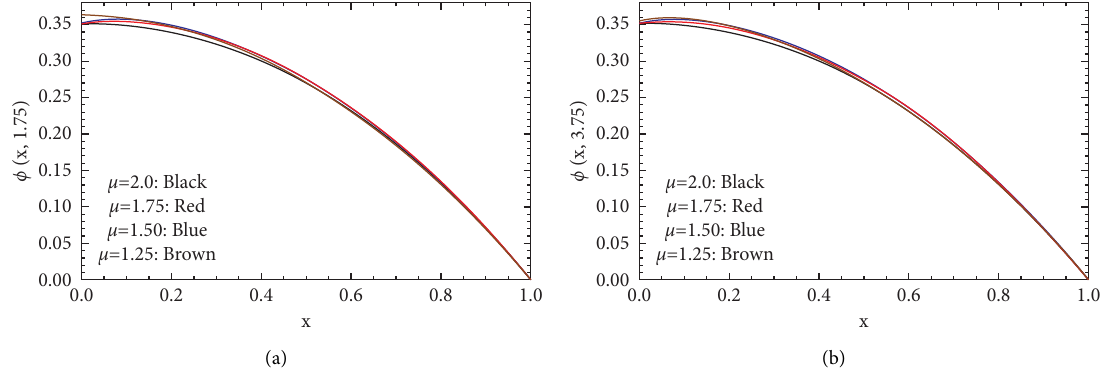
Figure 3: The approximate solution at F � 6 via different values of μ with T